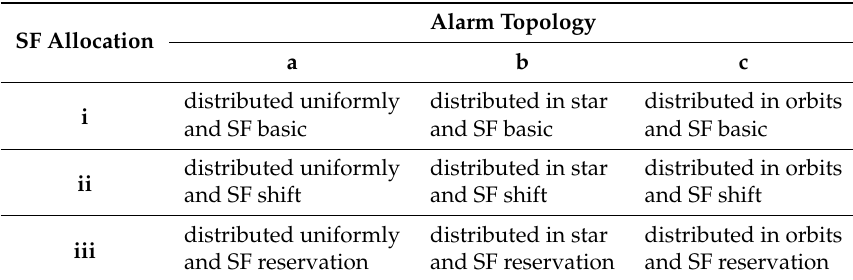
Table 3. Configurations of alarm topology and SF